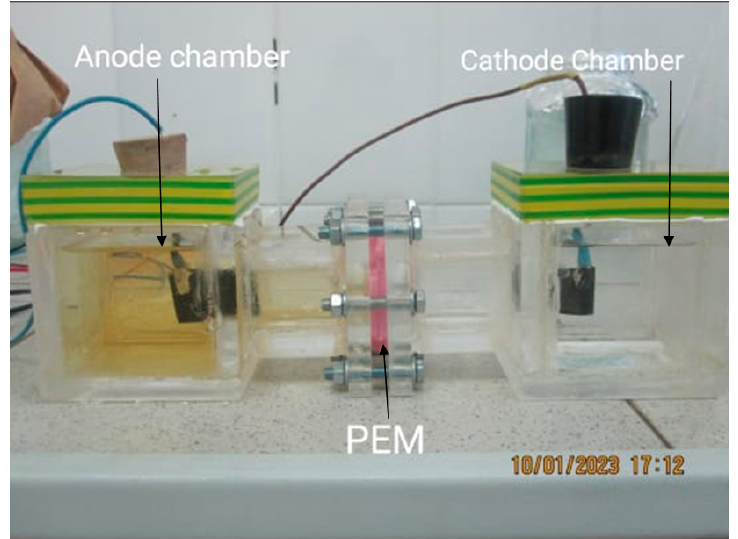
Figure 3. Dual-chambered microbial fuel